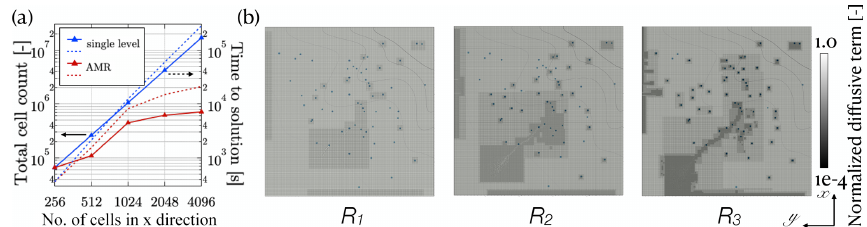
Figure 10. (a) Log–log plot of cell counts (plain lines with triangles) and execution times (dotted lines) versus resolution for the synthetic experiment and (b) example of mesh distribution for runs R 1 to R 3 overlayed on the locations of the moulins, normalized diffusive term (Sect. 2.3), and isocontours of bed elevation.